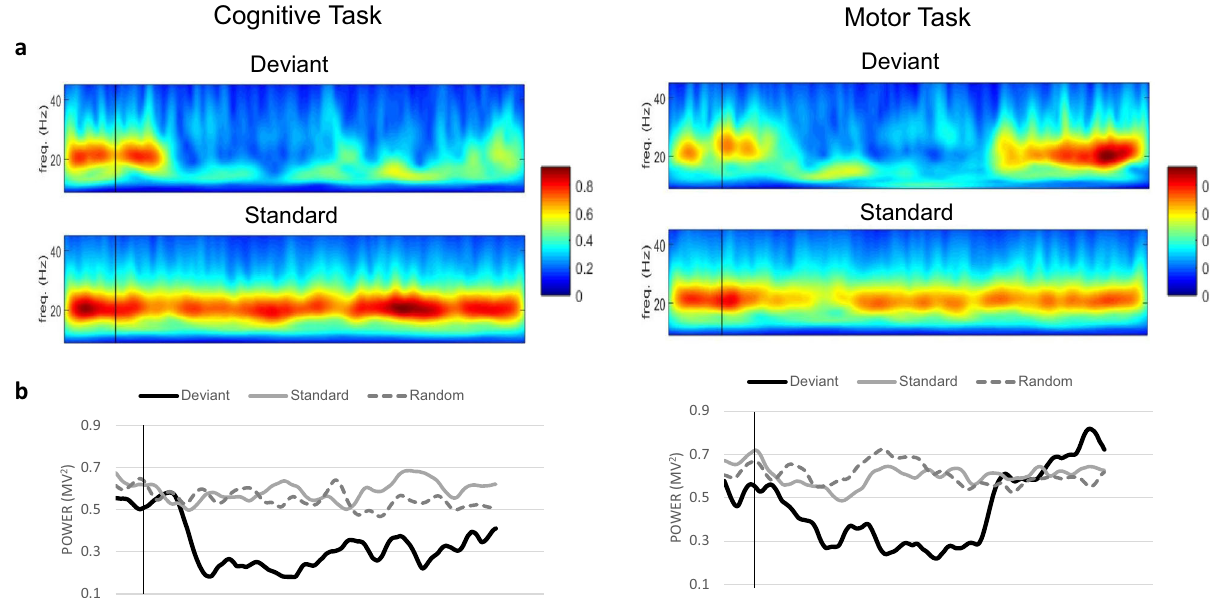
Fig. 6 Neuronal responses to the cognitive and motor tasks. a Event related spectral analysis (ERSA) of LFPs from open fi lter and smoothed microelectrode recordings in response to the cognitive task (Left) and the motor task (rapid wrist extension, Right). The ERSA is showing an individual example of the LFPs modulations where beta LFPs activity aligned to the onset of tones (black line). Top spectrogram is the beta LFPs response to the deviant tones and the bottom spectrogram is showing the response for the standard tones. The post-stimulus time frame is 1.8 s. Beta LFPs activity is showing a beta desynchronization around 0.2 s for both tasks but more prolonged desynchronization for the counting only task (cognitive task). b Line representations of the same examples for both tasks comparing beta LFPs activity for the deviant tones with standard tones and with random triggers.